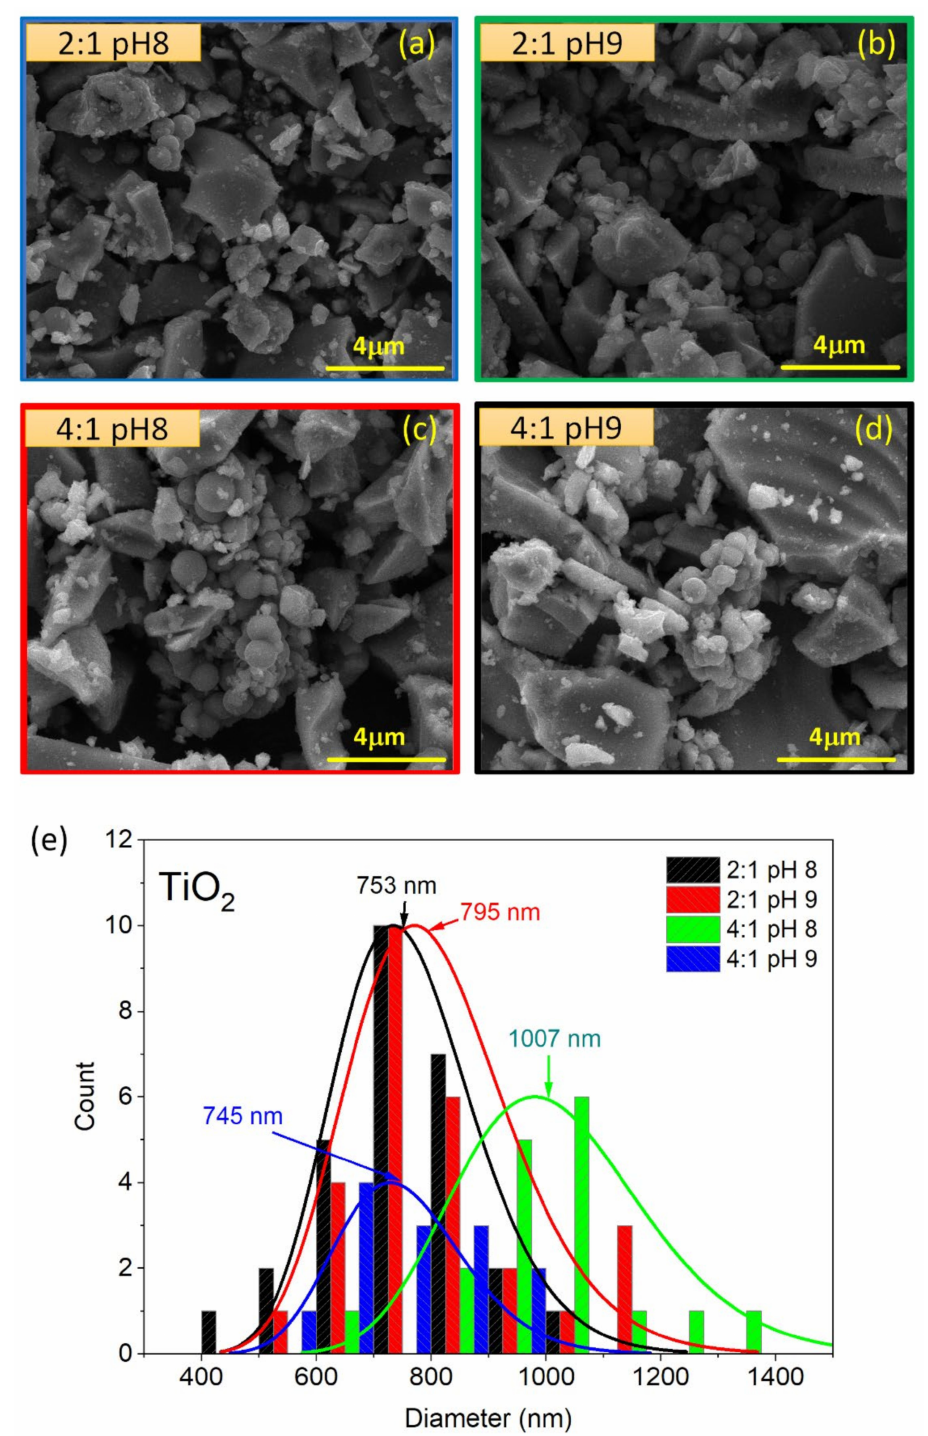
Figure 2. SEM images taken of TiO 2 powders grown with the molar ratio + pH ( a ) 2:1 pH8, ( b ) 2:1 pH9, ( c ) 4:1 pH8 and ( d ) 4:1 pH9. ( e ) Histograms of diameter distributions of the spheres. Lines correspond to the lognormal distribution